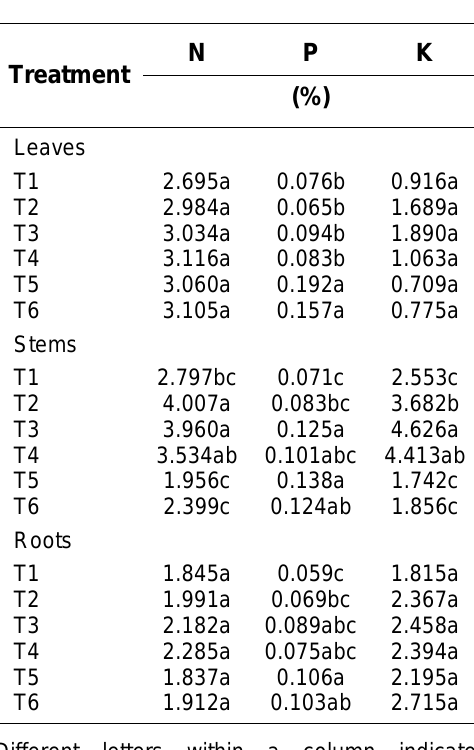
Effect of Different Treatments on Contents of N, P, and K in Leaves, Stems, and Roots of Maize Plants at 57 DAS